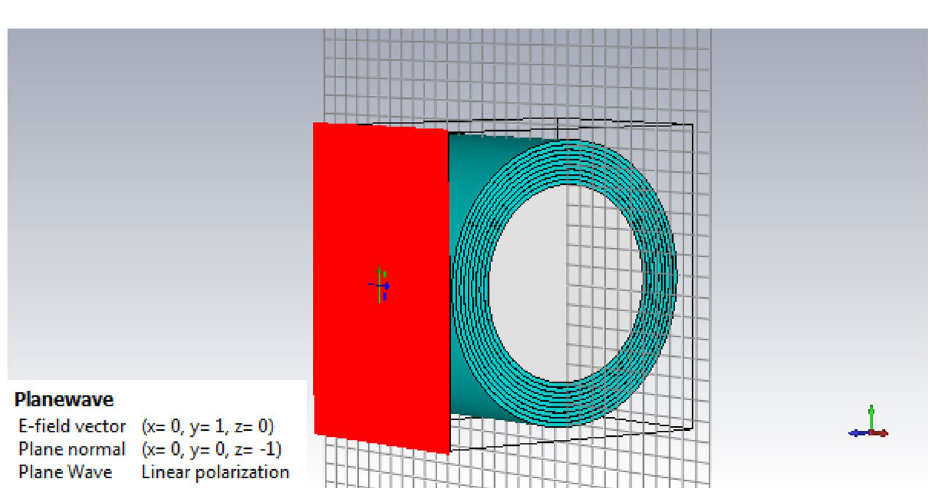
Figure 6. Simulation of plasma layers of surroundings around the